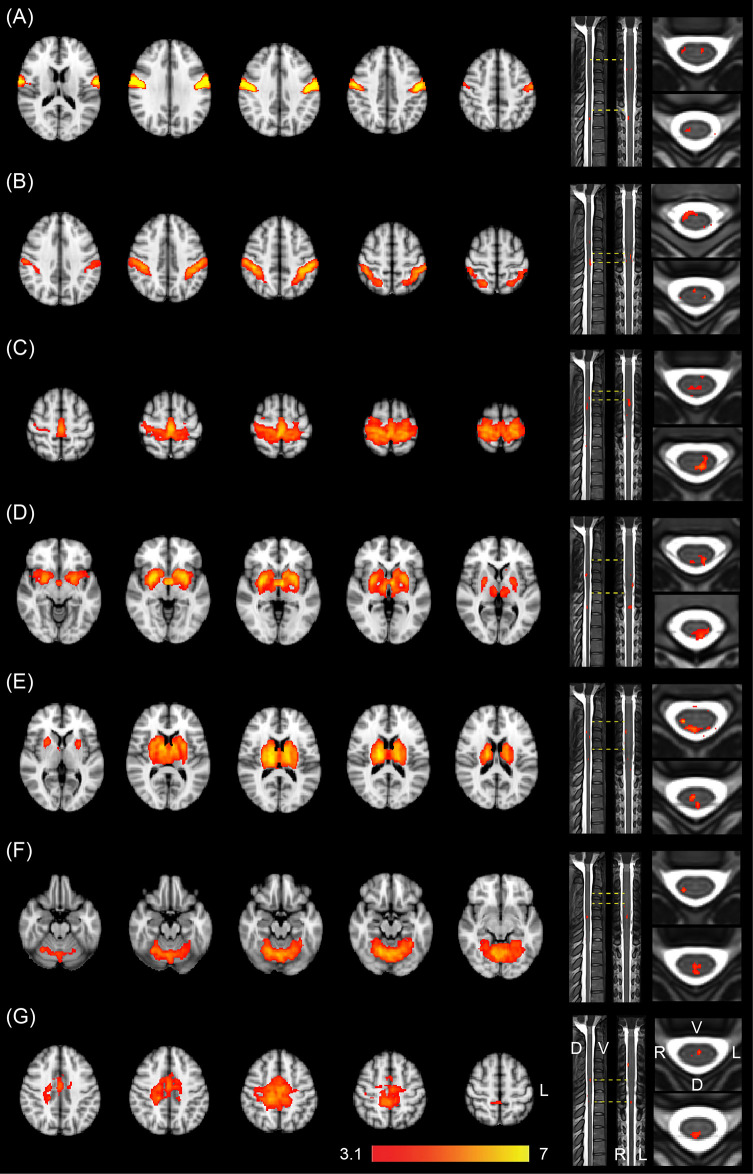
Joint ICA of brain and spinal cord RSNs.ICA revealed 7 distributed networks that include both brain and spinal cord clusters. At the brain level, these networks include bilateral primary motor cortex (A), somatosensory cortex (B), dorsal sensorimotor (C), basal ganglia (D), thalamus (E), cerebellum (F), and the supplementary motor area (G). At the spinal cord level, they mainly cover the ventral or medial regions (A, B), the dorsal regions (D, E, F), or both dorsal and ventral regions of the cervical cord (C, G). Each spinal cord component is presented, from left to right, in sagittal, coronal, and axial planes. Color-coded activation maps indicate z-score values, corrected p < 0.05. The numerical data used in this figure are included in S1 Data. D, dorsal; ICA, independent component analysis; L, left; R, right; RSN, resting-state network; V, ventral.